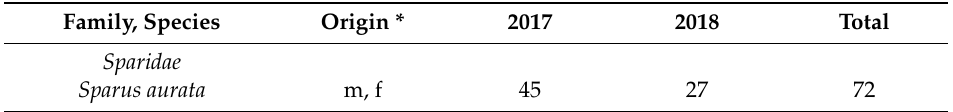
Table 2. Cultured Sparus aurata sampled and analyzed in this study. Total number of specimens tested and number of cultured fish farm sampled in 2017 and